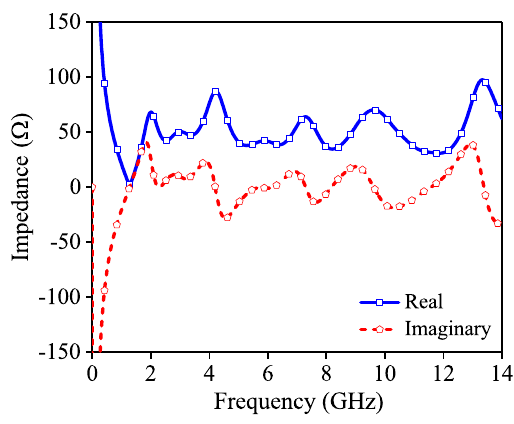
FIGURE 11: Proposed UWB antenna impedance.